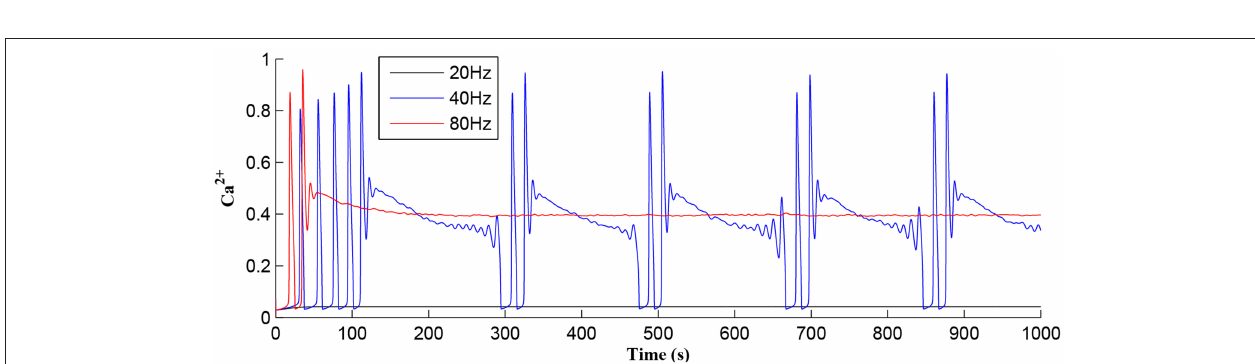
FIGURE 11 | Firing rate of the postsynaptic neuron where a continual bursting behavior is evident. The firing activity was calculated using a sliding time window of 10 s (blue) and again for a sliding window of 40 s (red) where the latter gives a better average.